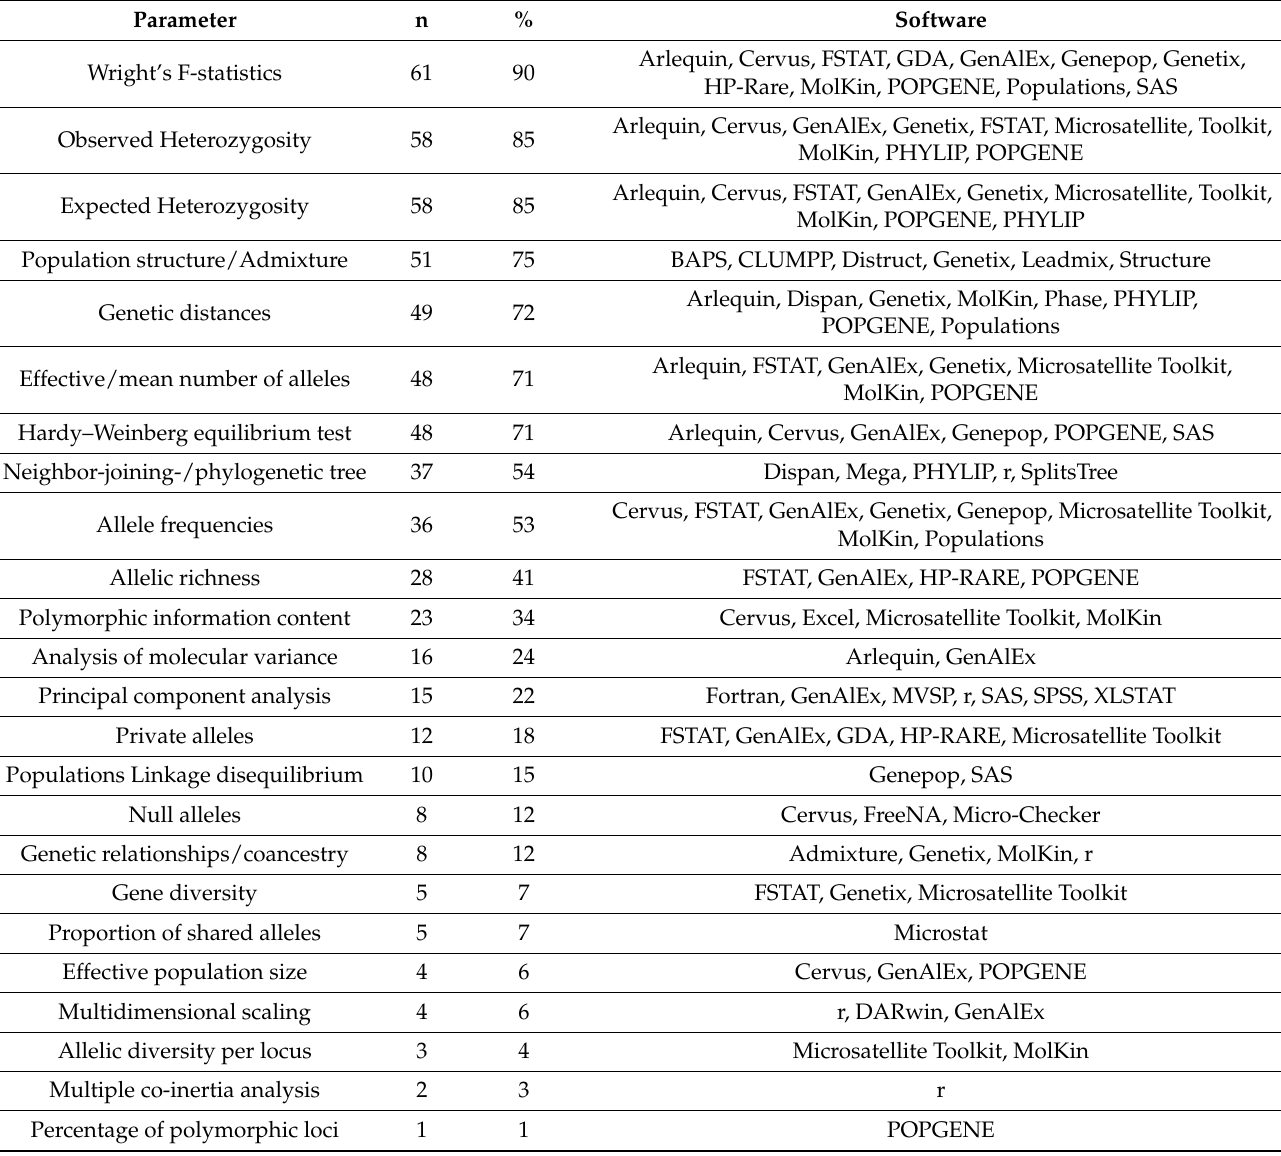
Table 1. Number and percentage of publications reporting different types of diversity parameters, estimated based on 68 studies and software used. Table from Olschewsky et al., 2021